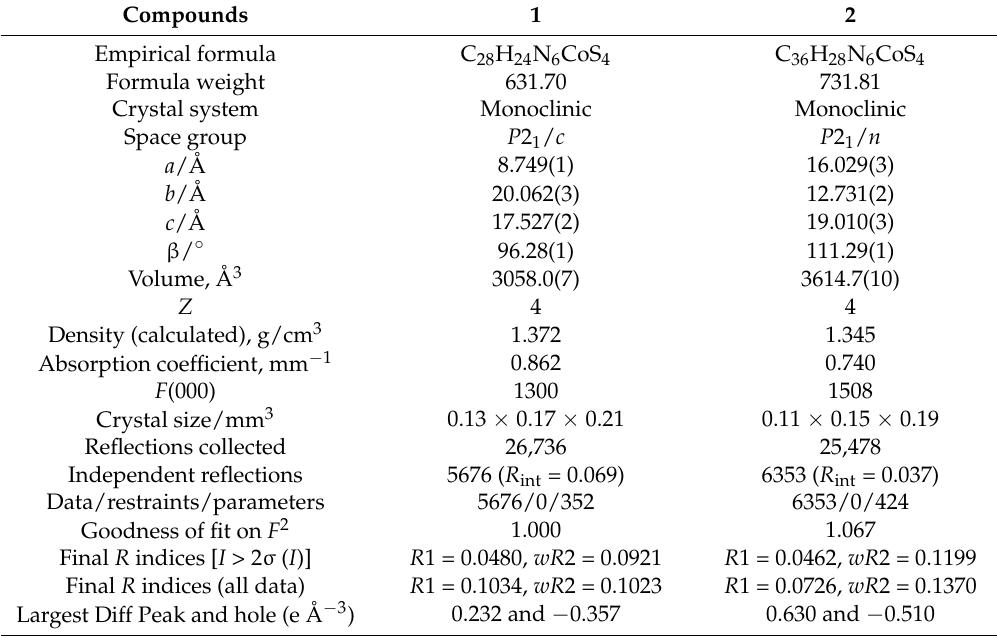
Table 3. Crystal data and structure refinement for 1 and 2